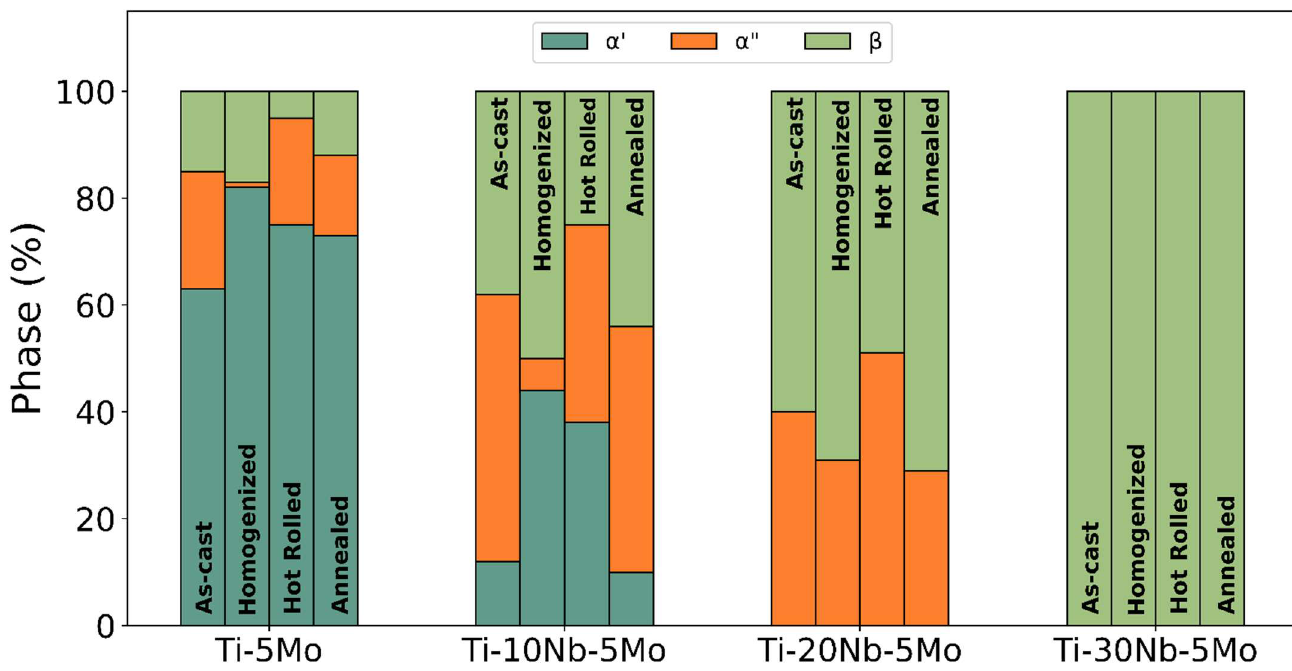
Figure 2. Phase composition of the Ti-xNb-5Mo samples, obtained by Rietveld’s refinement.